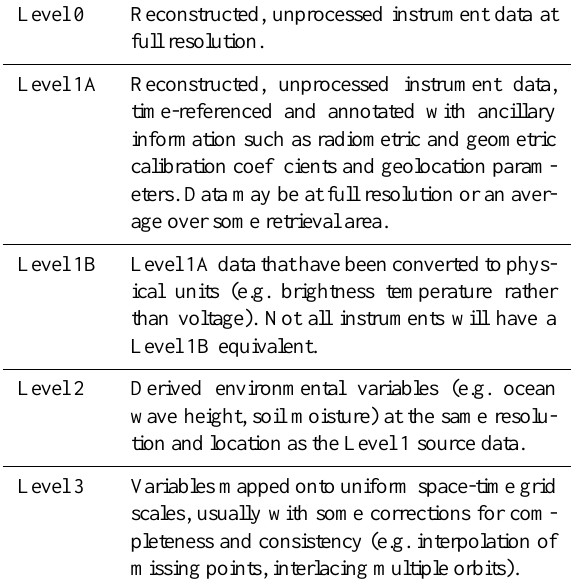
Table 1. Satellite data processing levels, adapted from Chase (1986). Level 0 Reconstructed, unprocessed instrument data